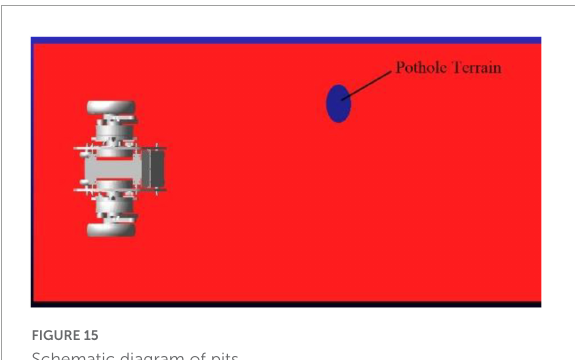
FIGURE15 Schematic diagram of pits.